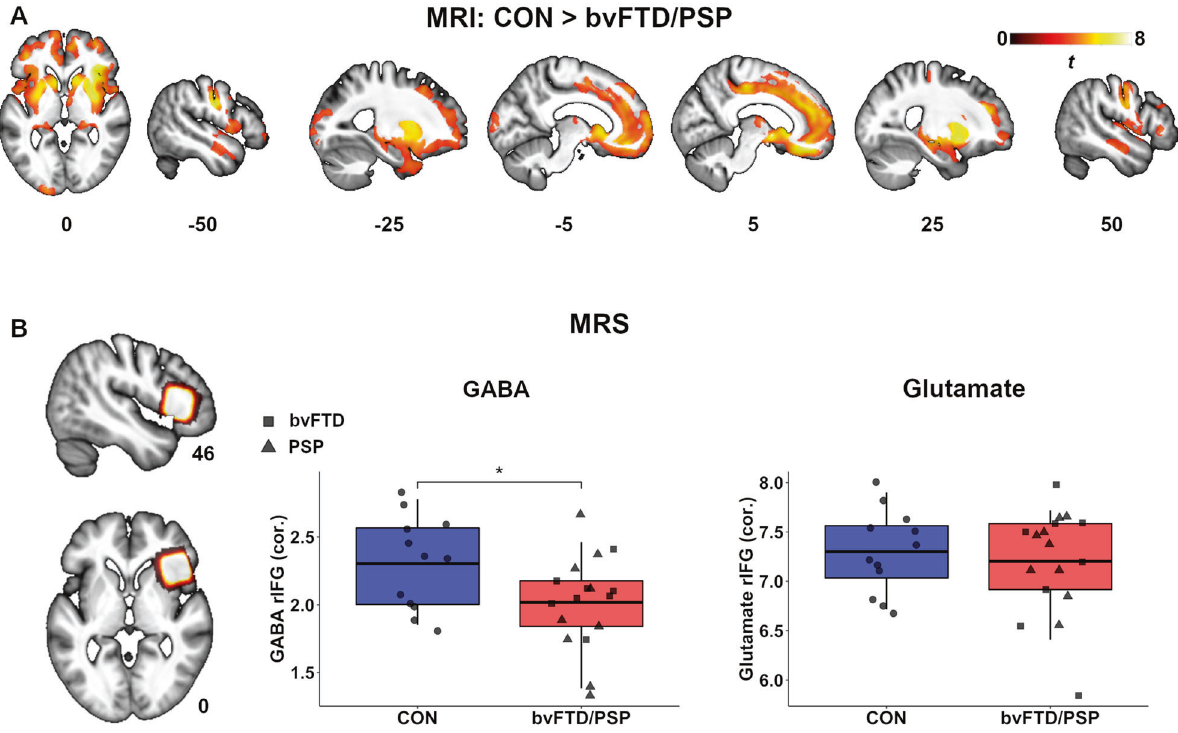
Fig. 1 Neuroanatomical and neurochemical differences across controls and persons with bvFTD/PSP. A Group-wise voxel-based morphometry comparisons between controls and patients (cluster-level, p < .05, FWE-corrected; height-threshold, p < 0.001, uncorrected). Unthresholded SPM maps are available at https://neurovault.org/collections/12279. B MRS concentrations of GABA (left panel) and Glutamate (right) in the right inferior frontal gyrus for both controls and patients (bvFTD, squares; PSP, triangles) corrected for age, sex and partial-volume information (grey and white matter for glutamate, grey matter for GABA). Heat voxel image (far left panel) represents sum of all participants MRS voxel placement in the frontal cortex. Anatomical images are the mean brain extracted structural image across all controls and patients. * p < .05, uncorrected. bvFTD behavioural variant frontotemporal dementia, PSP progressive supranuclear